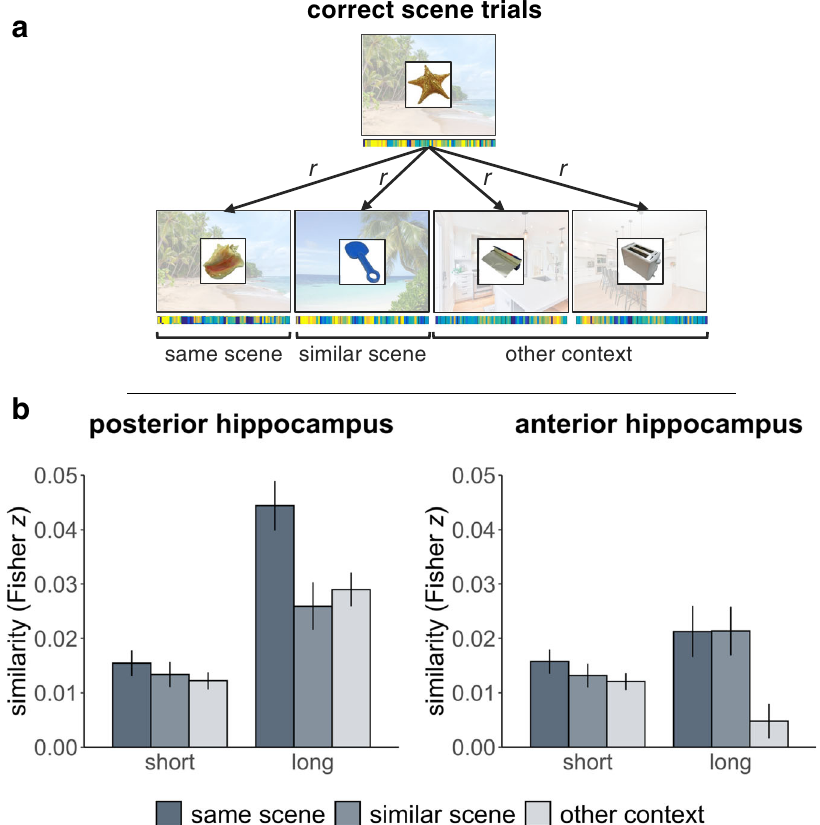
Fig.5|Representationalsimilarityanalysisofobject-scenepairsretrievedwith detail in the hippocampus. a Schematic example of our analysis approach. Pat- terns for successfully retrieved object-scene pairs were extracted from the right anterior and posterior hippocampus and correlated with objects that had shared thesamescene,hadbeenpairedwiththesimilarsceneofthesamecontext,aswell as those that had been paired with scenes from the other context. This example depicts congruent correlations for one of the beaches, but the same analysis was applied to the other beach, as well as to both kitchens, within congruent and incongruent conditions. Background scenes were not presented during retrieval, butwereretrievedfrommemory. b Resultingpatternsimilarityintheposteriorand anterior hippocampus over time, according to scene/context overlap. Note thatas